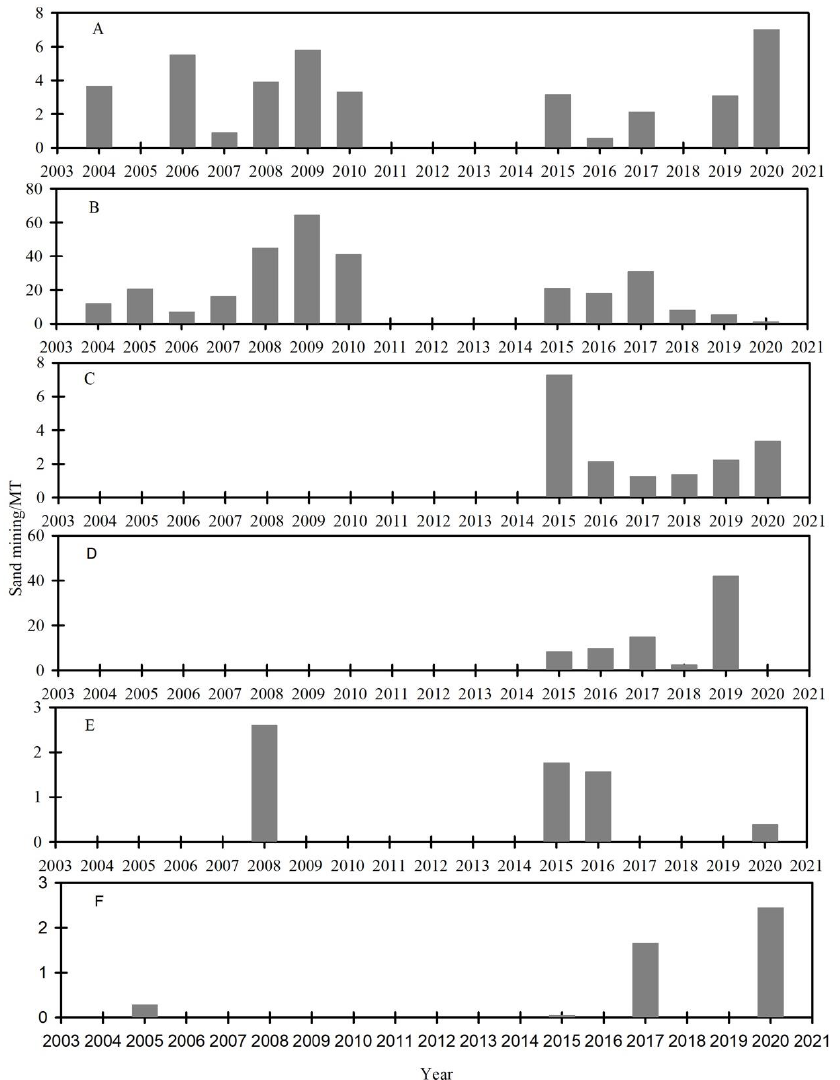
Figure 3. Sand mining within the YRB from 2004 – 2020: ( A ) Hubei Province; ( B ) Jiangsu Province; ( C ) Chongqing City; ( D ) Shanghai City; ( E ) Anhui Province; ( F ) Jiangxi Province.